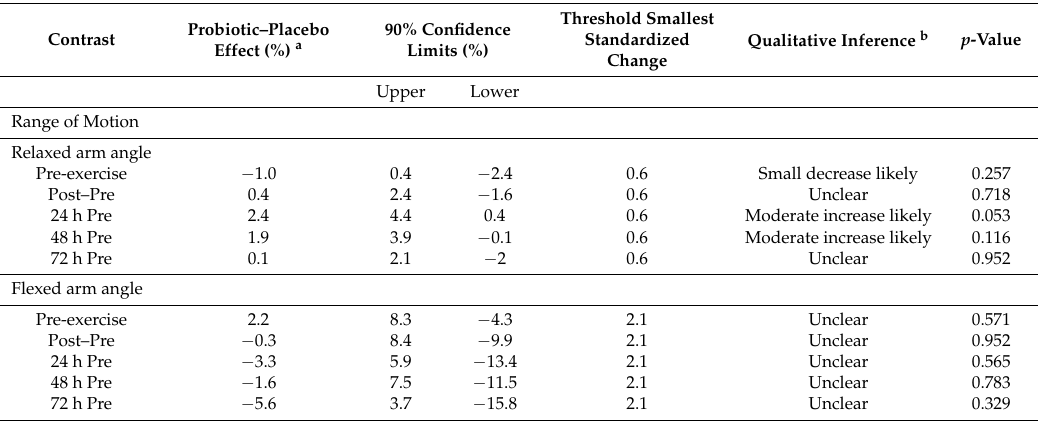
Figure 2. Effect of 21 days of probiotic and placebo supplementation on muscle soreness as measured with the visual analogue scale (VAS) for the exercised (EX) arm and non-exercise (NONEX) arm. Data are raw means and SD. All probiotic–placebo post–pre exercise contrasts were unclear [24]. Table 1. Statistical summary for the effect of 21 days of probiotic and placebo supplementation on arm range of motion.